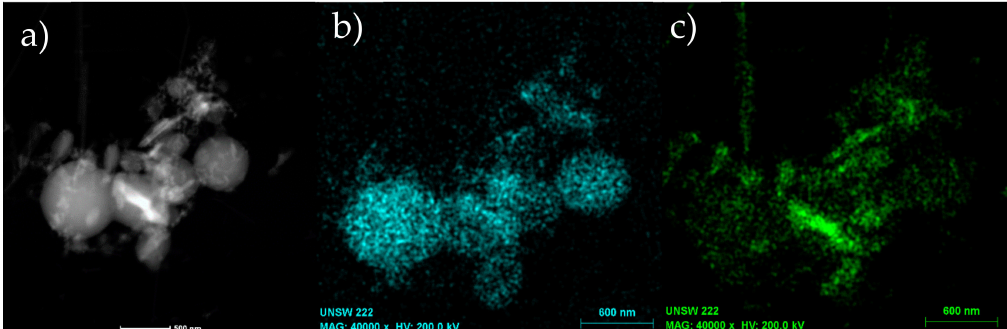
Figure 9. TEM backscattered images of a sample heat treated at 1500 ◦ C for 5 min after separation of Al nanoparticles and Al-Si nano-rods. ( a ) TEM backscattered image, ( b ) EDS map of Al, and ( c ) EDS map of Si.